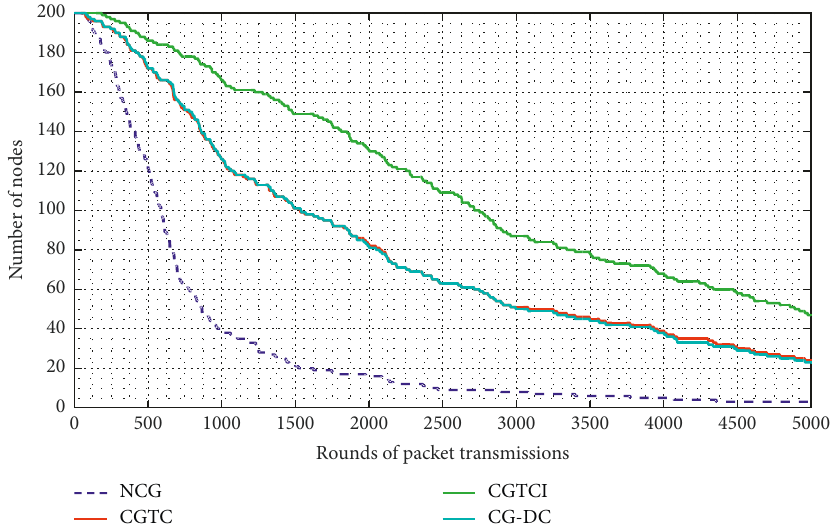
Figure 12: Trend of the number of surviving devices in the